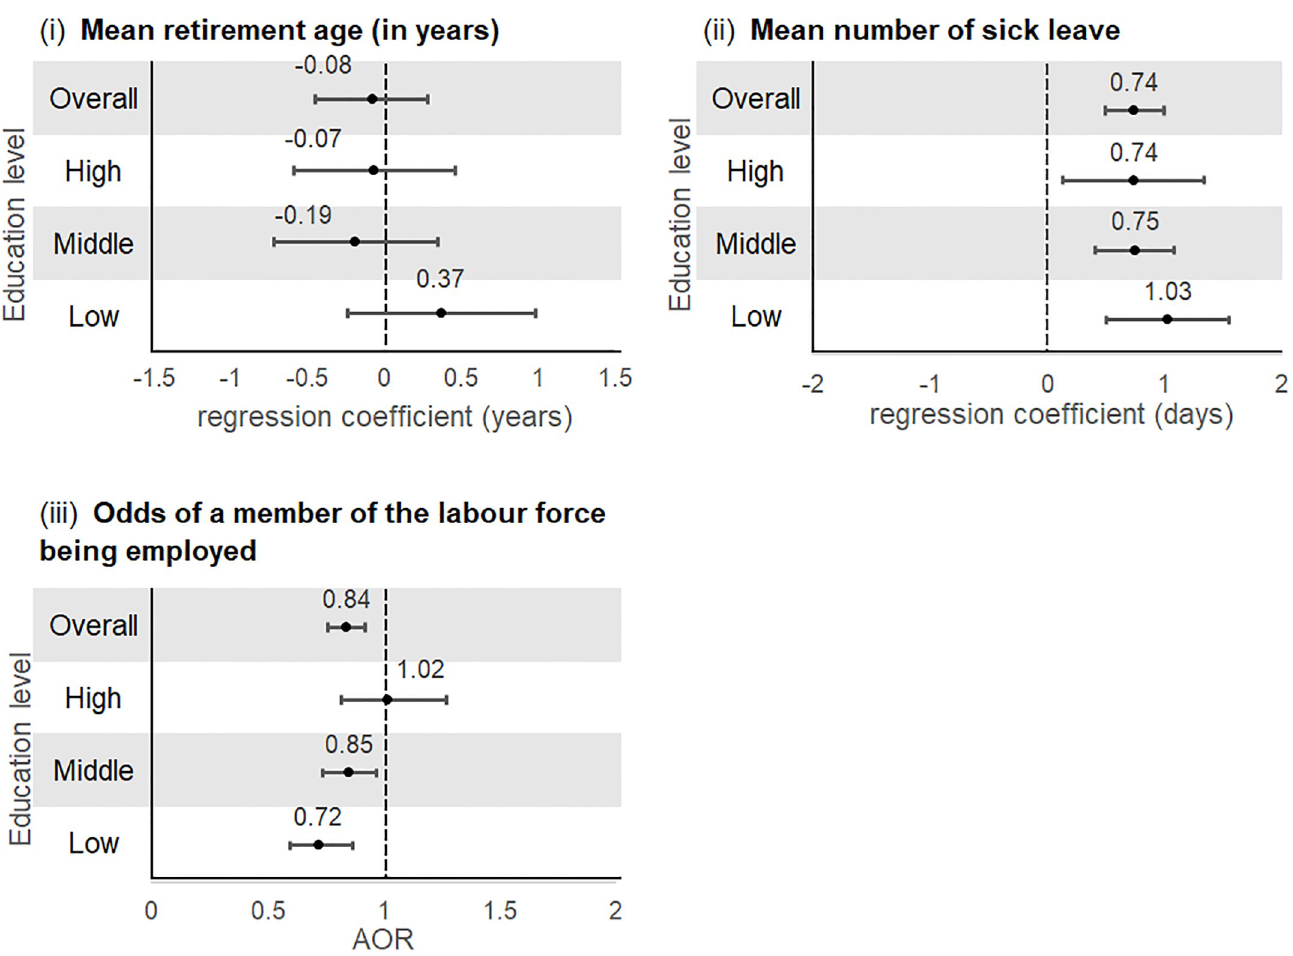
Fig 8. Associations between multimorbidity with (i) mean retirement age (ii) mean number of sick leave days and (iii) odds of being unemployed by education level (Japan) + . + Multivariable negative binomial regression models and multivariable logistic regression models were adjusted for age, sex, marital status, body mass index, physical activity, alcohol intake, and